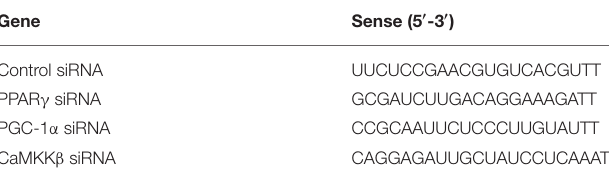
TABLE 2 | Sequence of target gene siRNA.